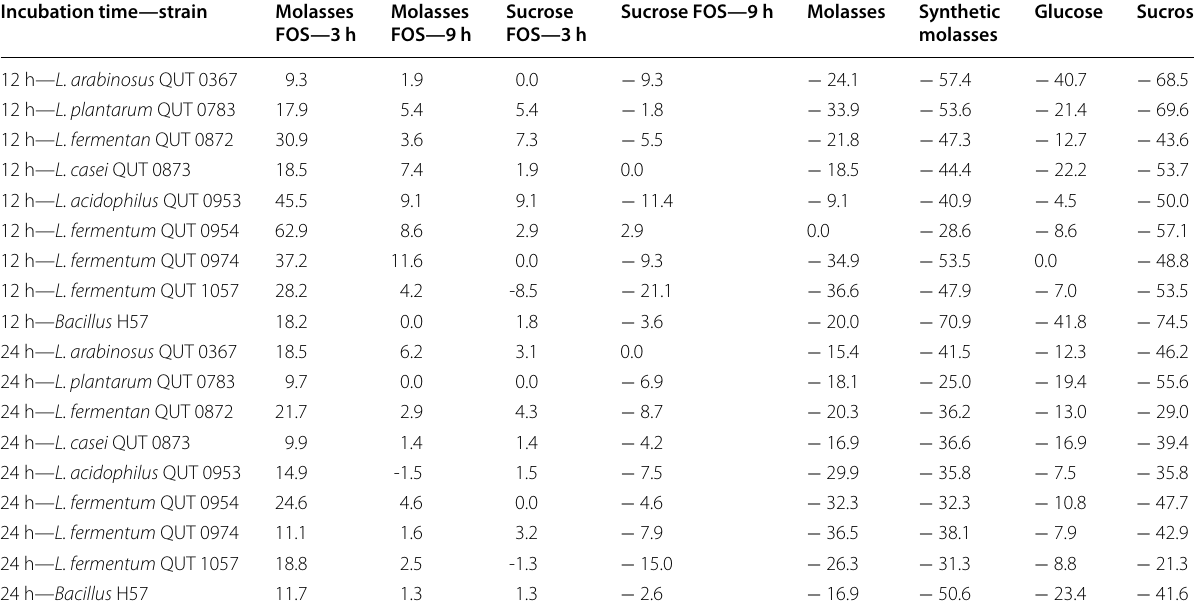
Table 3 Cell growth improvements (%) of probiotics compared with the commercial FOS (Nutraflora P95) Incubation